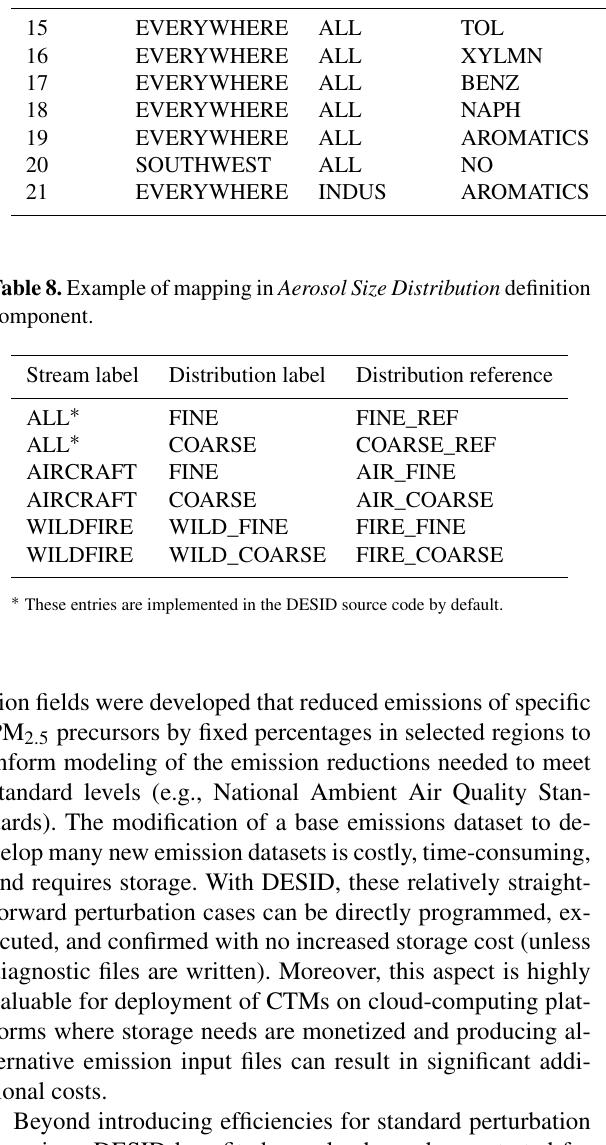
Table 7. Scaling examples using chemical, stream, and region families. Example